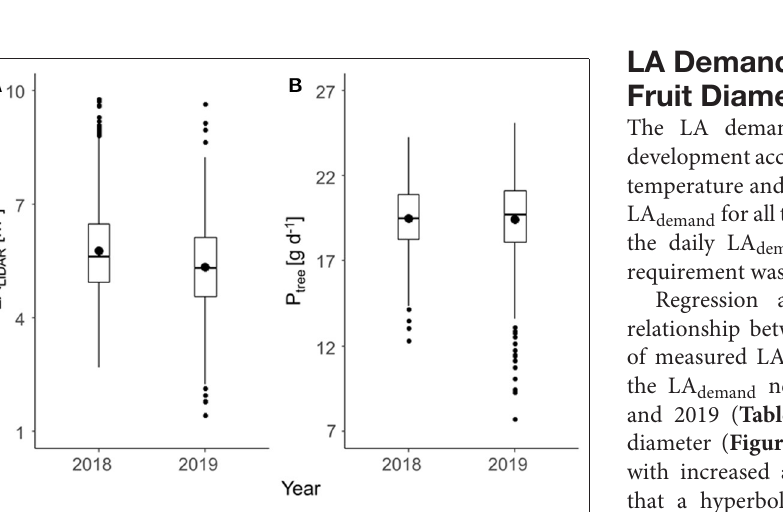
FIGURE 4 | Total leaf area (LA) per tree estimated with light detection and ranging (LiDAR) (LALiDAR) of a fully developed canopy (A) and mean daily assimilated C per tree (Ptree) in the period of maximum daily fruit carbon requirement (B) of ‘Gala’/M.9 apple trees in two consecutive years. Lower and upper hinges of boxplots correspond to the first and third quartile, the dash inside the box to the median, and the dot to the mean